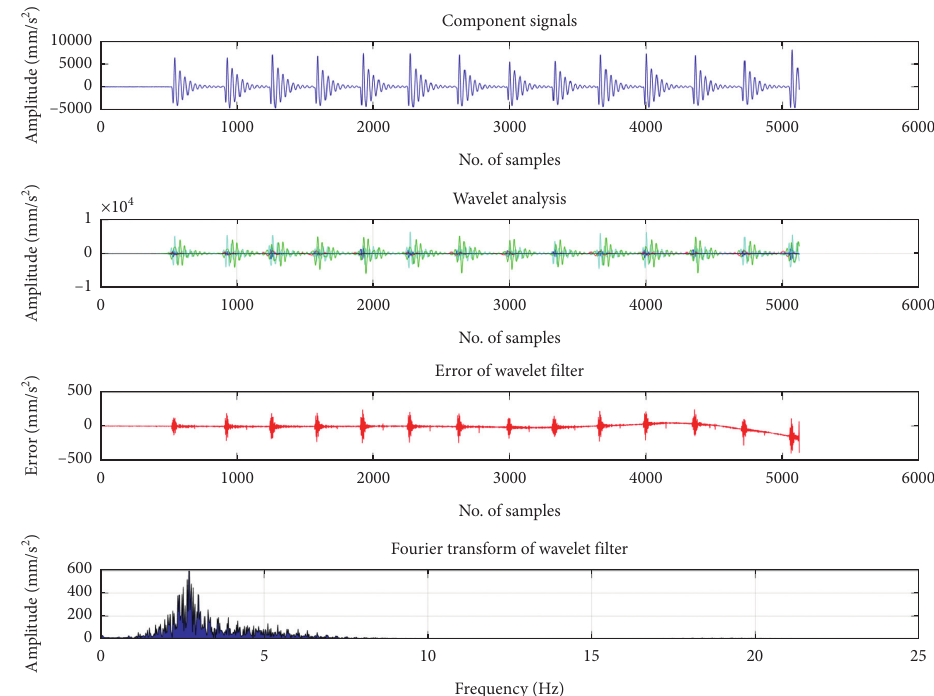
Figure 9: Signal of vehicle model carrying out multiple vibrations on the structure in case 1.